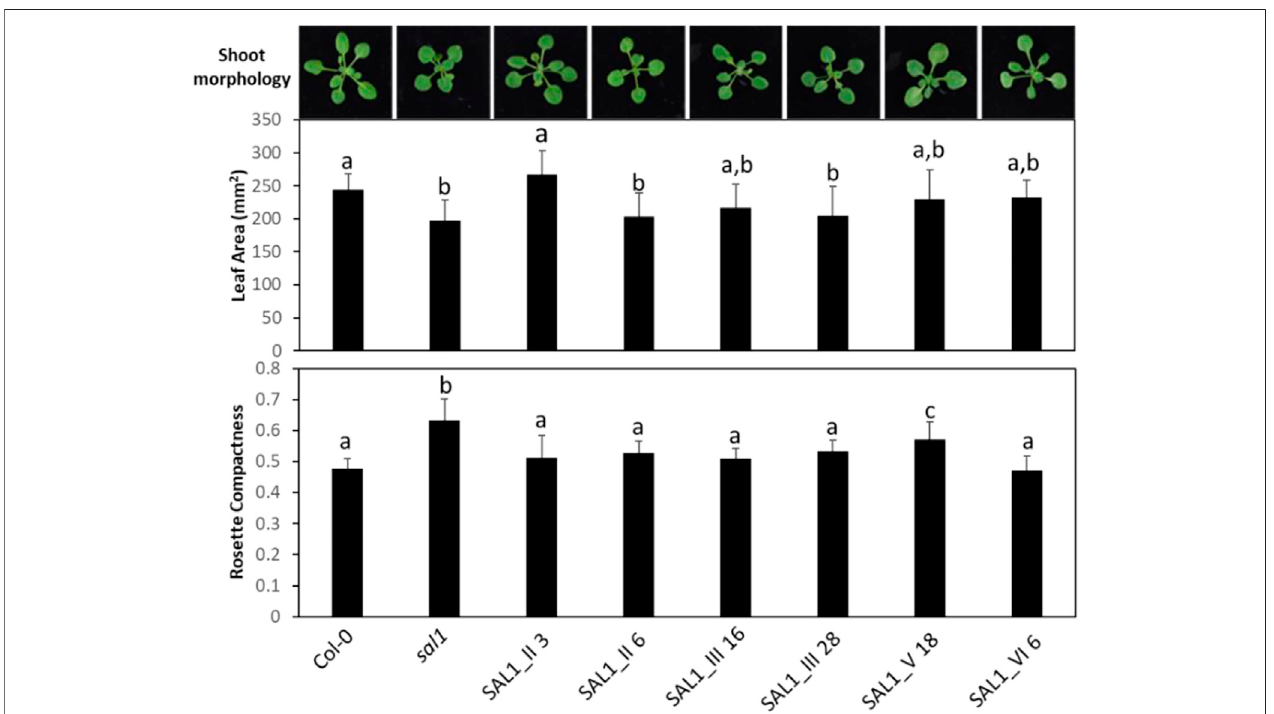
FIGURE 8 | Shoot morphology, leaf area, and rosette compactness in complemented sal1 mutant lines expressing SAL1 mRNA at similar levels. Morphological phenotypeswereanalyzedinrosetteleavesof25-day-oldsoil-grownplants.Theentireabovegroundrosettewasexcisedandphotographedunderstandardizedlighting conditions, then the image analyzed using ImageJ to quantify the leaf area and rosette compactness. All lines shown here have SAL1 mRNA overexpressed at ∼ 10-fold thelevelsofCol-0.Datashowthemean ± SD( n (cid:1) 5). Differentletters indicatesigni fi cantdifferencesamongmeansbasedonone-wayANOVAandTukey ’ shonestly signi fi cantdifference (HSD) post-hoc test at p < 0.05.Note that,similarto Figure7 ,there waseithercomplete orserious lossin germination rateand/or seedlinggrowth in lines of interest, which were not seen in earlier experiments (e.g., lines I_61, IV_19, IV_26, and V_13). We decided to omit representatives from certain lines (e.g., construct IV) because no other representative within that construct had similar SAL1 mRNA expression to the rest of the constructs. However, we attempted to compensateforthisde fi ciencybystudyingtworepresentativesofcertainconstructs(IIandIII),incaseswheretheyhavesimilarSAL1mRNAexpressiontotherestofthe